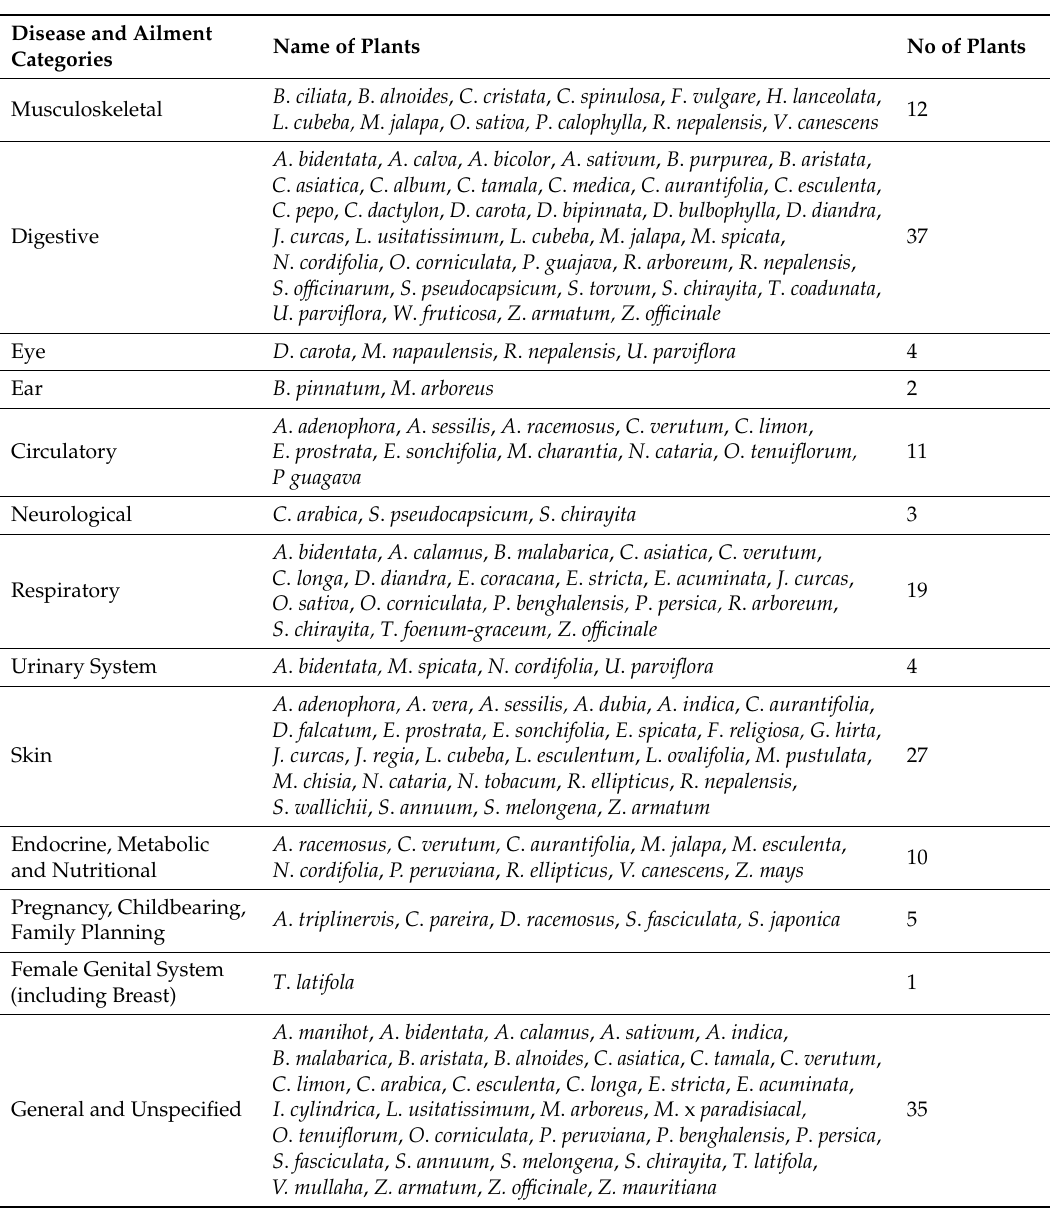
Table 2. List of plant species used for specific categories of diseases and